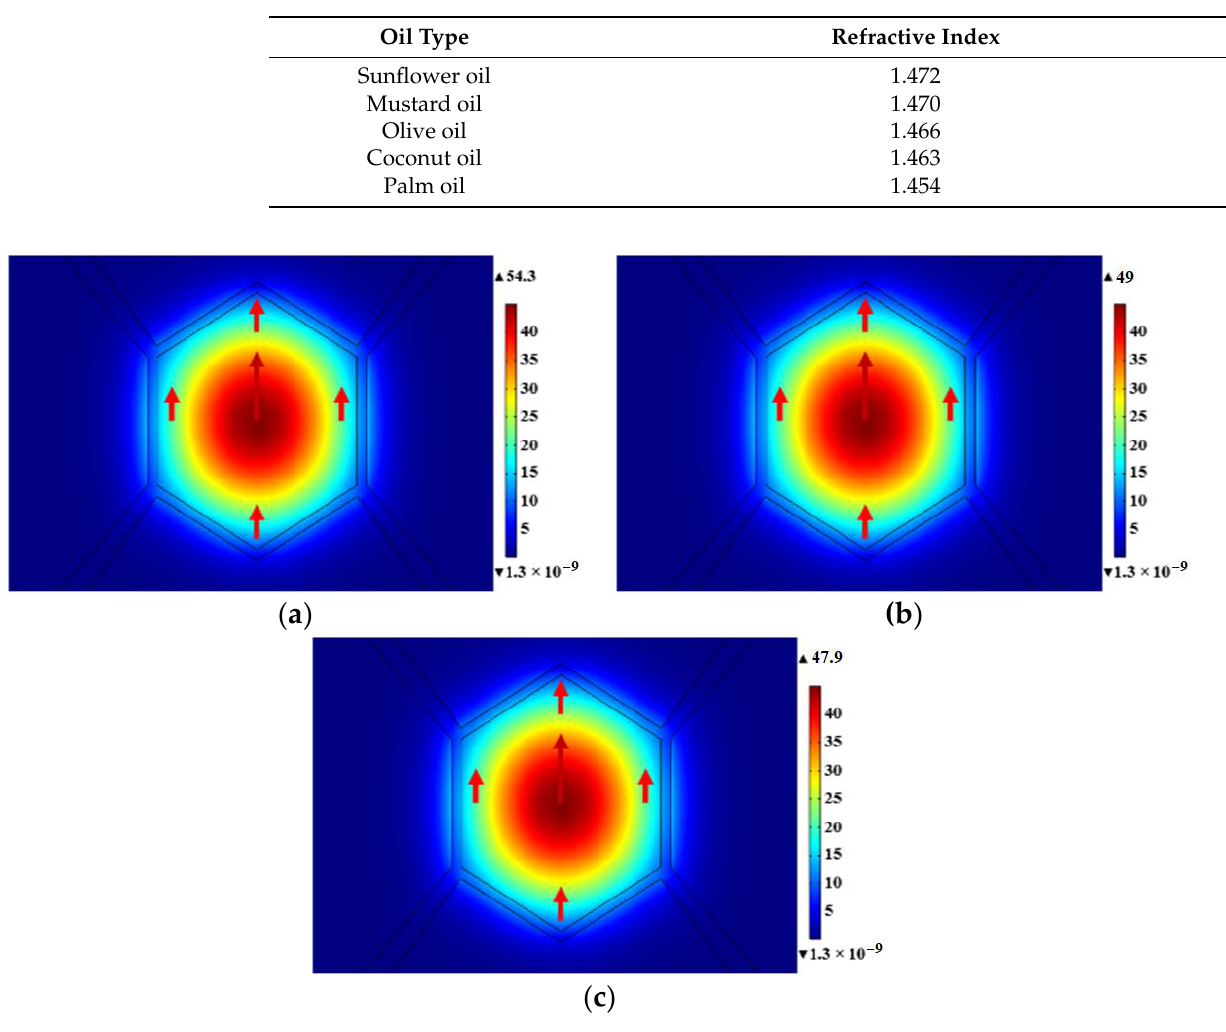
Figure 2. Electric field distribution of the proposed sensor for ( a ) Sunflower oil, ( b ) Mustard oil and ( c ) Olive oil